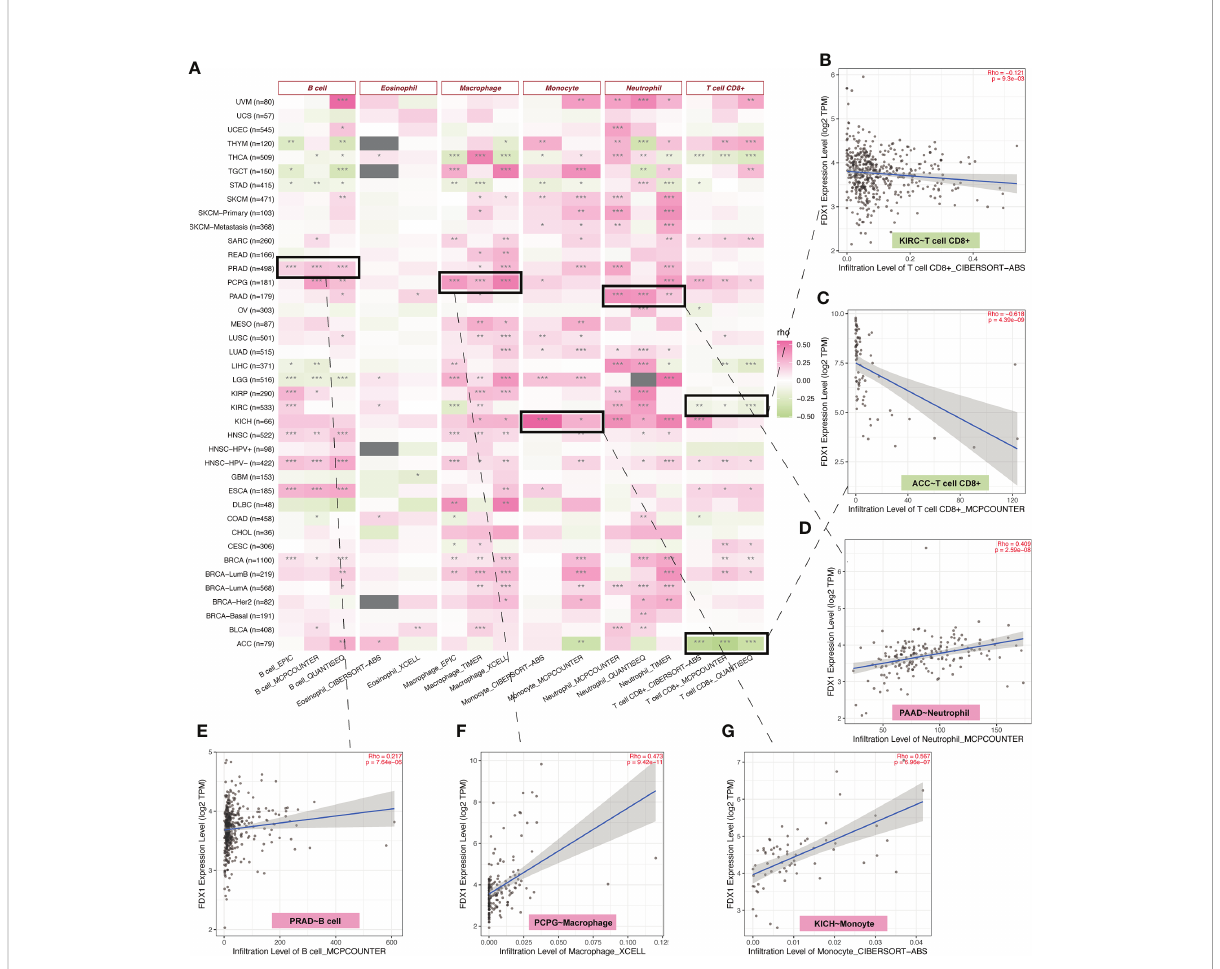
FIGURE 4 Immune in fi ltration analysis of FDX1 . (A) The correlation heatmap between the six immune cells and FDX1 expression in tumors based on two or three algorithms. (B – G) The correlation plot of those having consistent r values based on the different algorithms. ns, not signi fi cant, p ≥ 0.05; *p < 0.05; **p < 0.01; ***p <